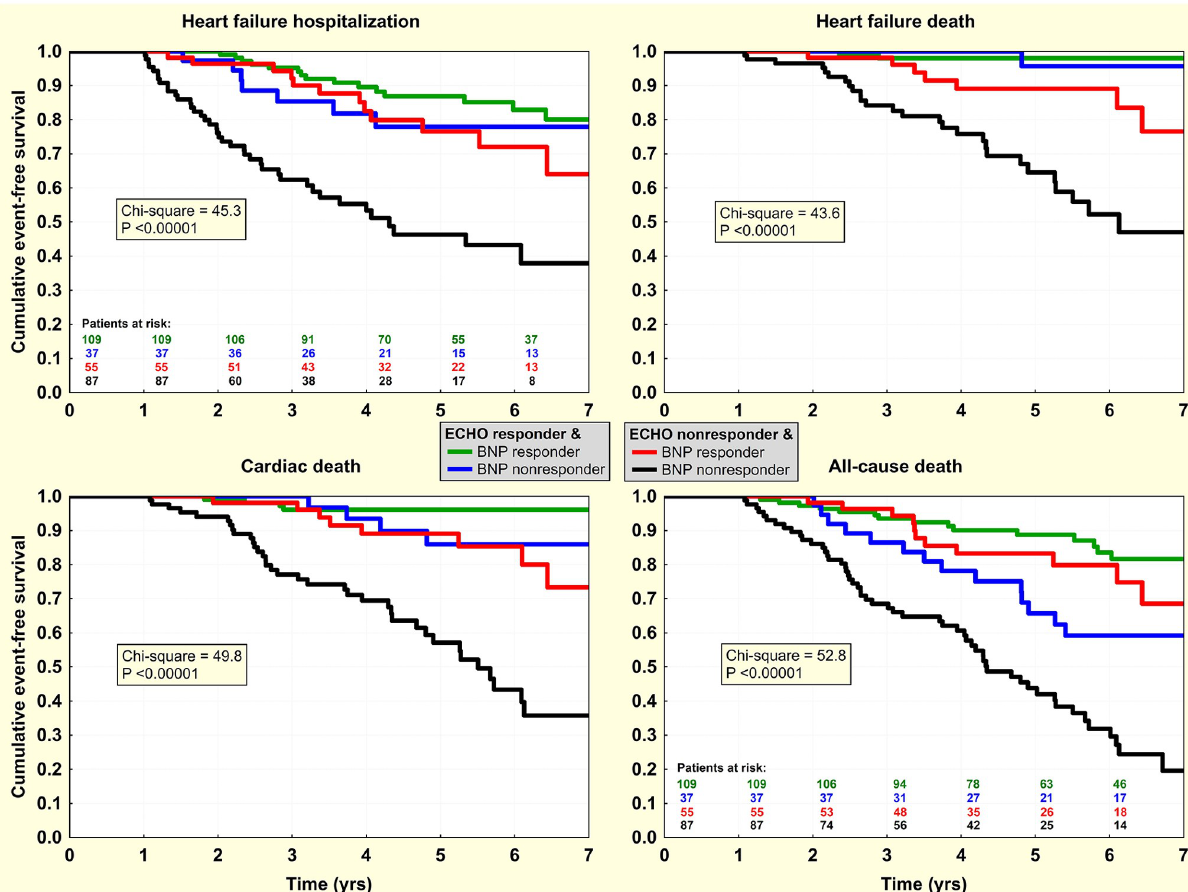
Fig 4. Event-free survival in 4 categories of post-CRT response. Kaplan-Meier curves for the first heart failure hospitalization / death and cardiac / all- cause death according to „ECHO response”(LVESd relative change < -12.3%) and „BNP response”(NT-proBNP < 1230 ng/L at Month 12 after CRT).